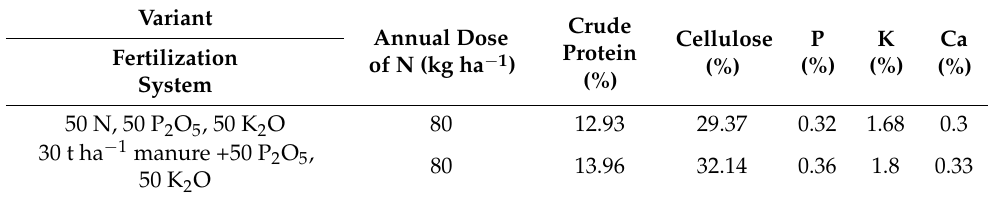
Table 6. The influence of the fertilization system on the chemical composition of feed.